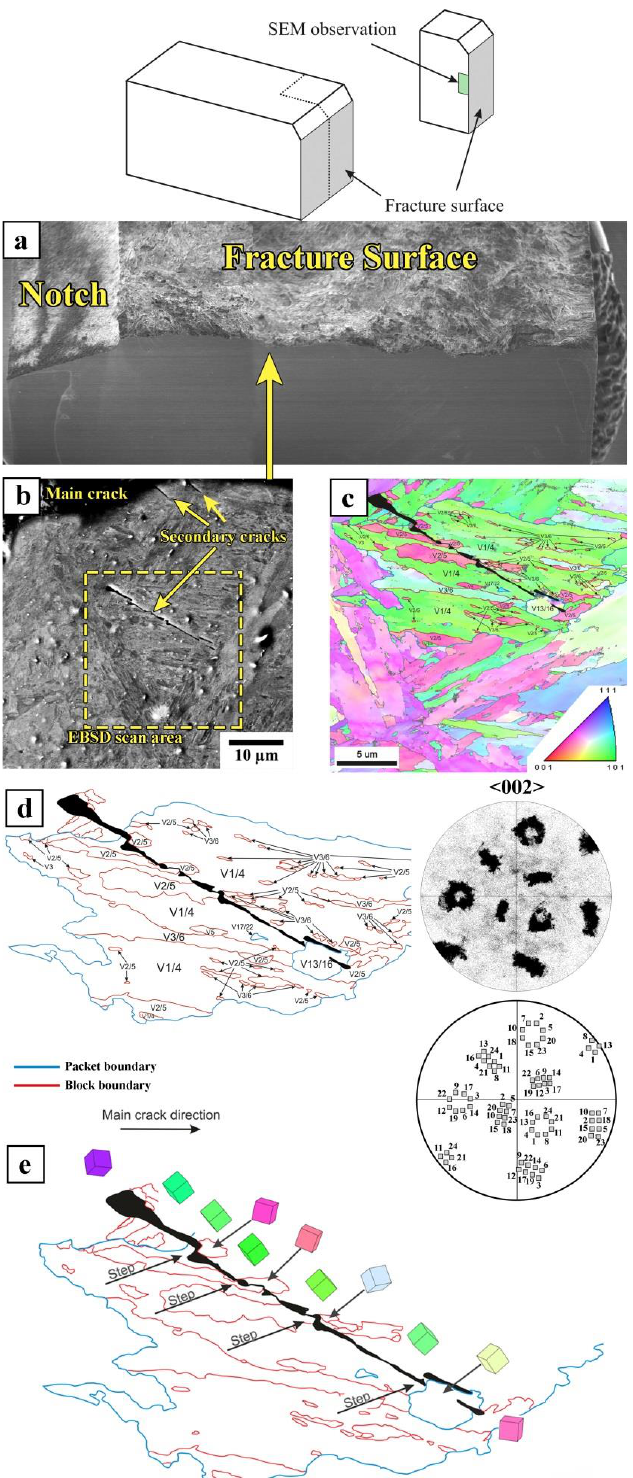
Figure 11. SEM analysis of the secondary crack propagation in the NT sample tempered at 500 °C: schematic and overall view of the ruptured Charpy specimen ( a ); SEM cross section image revealing secondary cracks near to fracture surface ( b ); IPF map of the selected EBSD scan area ( c ); the variant analysis of the lath martensite structure along the observed secondary crack and theoretical <002> pole figure of martensite variants inside an austenite grain satisfying the K-S OR ( d ); the grain boundary map showing the appearance of the crack deflection and corresponding three-dimensional crystal orientations represented by unit cell cubes at the fracture surface ( e ).